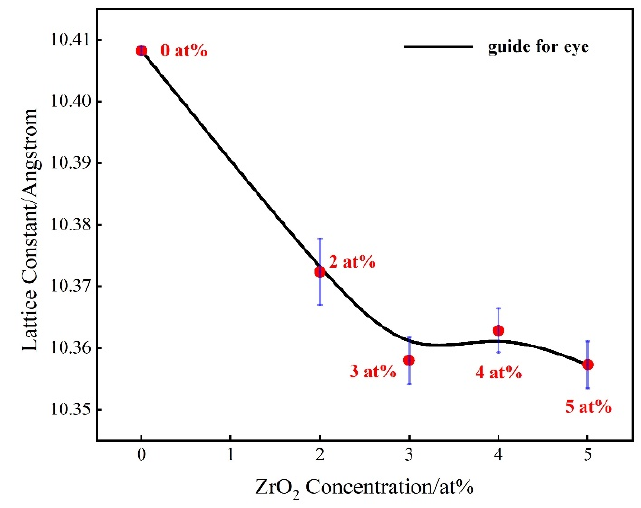
Figure 2. Change in lattice constants with varying Zr concentrations.